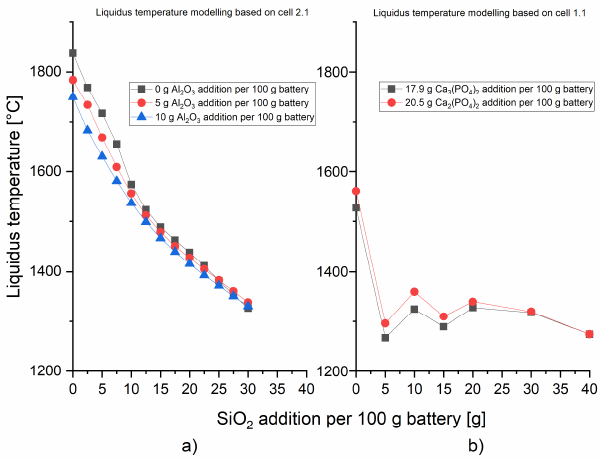
Figure 1. Liquidus temperatures modeled with FactSage TM 8.0 [75] for ( a ) Cell 2.1, and ( b ) Cell 1.1, which are related to the SiO 2 addition. As the influences of P and Ti on the slag mineralogy were to be investigated, two slag systems were chosen on the basis of the composition of Cell 1.1. Similar to Cell 2.1, the relation between the liquidus temperature and the SiO 2 addition was modeled. Because the system does not contain P, different amounts of Ca 3 (PO4) 2 were investigated as well. On the basis of Elwert et al. [18], the relation of the REE:PO 43- was set to 1:1. In addition, a higher P content was examined. As is shown in Figure 1b, a larger amount of Ca 3 (PO 4 ) 2 does not have a huge influence on the liquidus temperature and, therefore, the over- stoichiometric P addition was chosen for the trials. The SiO 2 addition was set to 20 g/100 g of the battery material (ASSB-7), which leads to a modeled liquidus temperature of 1340 °C. Smaller addition rates would suffice to decrease the liquidus temperature to 1500 °C, but a deviation that is due to the comparatively high La content, which is not contained in the model, is expected. To investigate the influence of P, System Cell 2.1, with an addition of 30 g of SiO 2 and 11 g of CaO per 100 g of battery material, was chosen (ASSB- 10) as the P-free reference. A larger amount of SiO 2 than in ASSB-7 was selected as the replacement for the P 2 O 5 and the similar basicity of the slag. 4.2. Bulk Chemistry of the Melt Experiments Three interesting SyS resulted from the set of experiments that were conducted via the approach described in Section 4.1: one with P and Ti; one with P; and one without P and Ti (Table 3). Table 3. Chemical bulk compositions of three SyS samples. wt.%